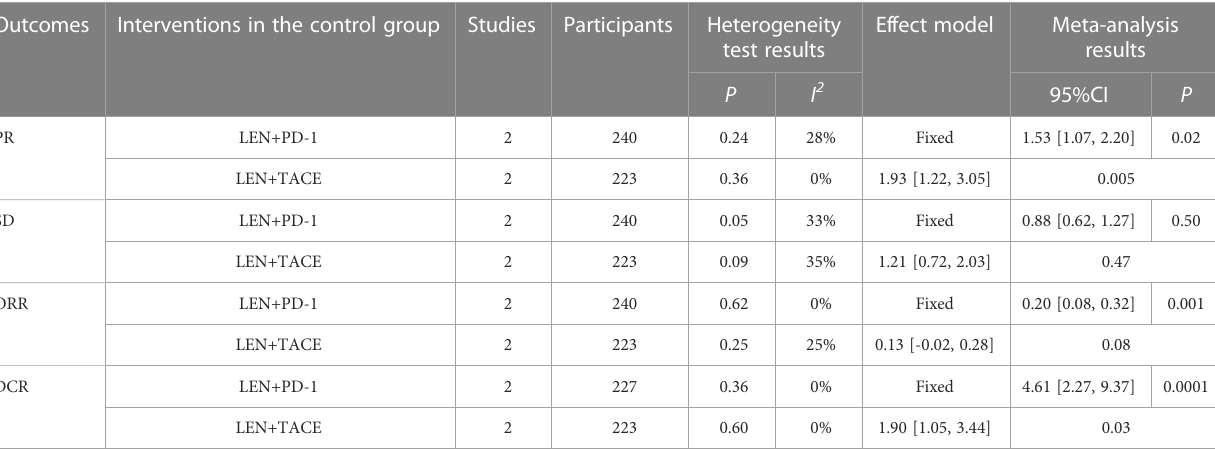
TABLE 3 Response outcomes - Subgroup analysis.